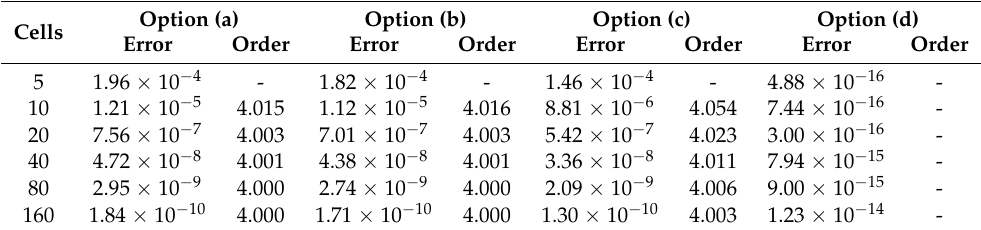
Table 1. Test 1.1. L 1 errors at t = 5 and convergence rates for CLWBM3 when option (a), (b), (c), and (d) are chosen to compute the initial cell averages.